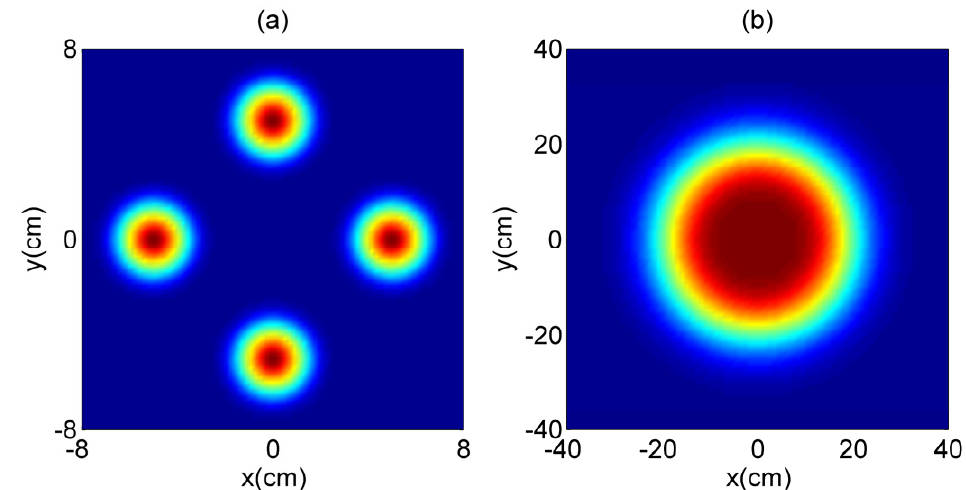
= 4 in free space. ( a ) z = 50m,